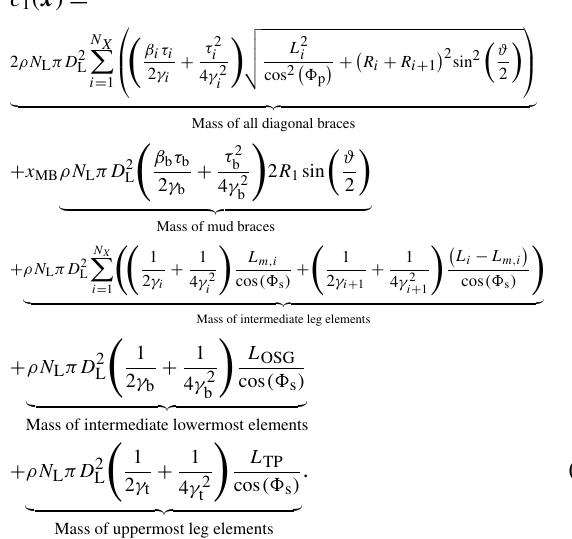
Figure 3. The i th jacket bay topology projected to the layer of X and double-K joints on one side of the